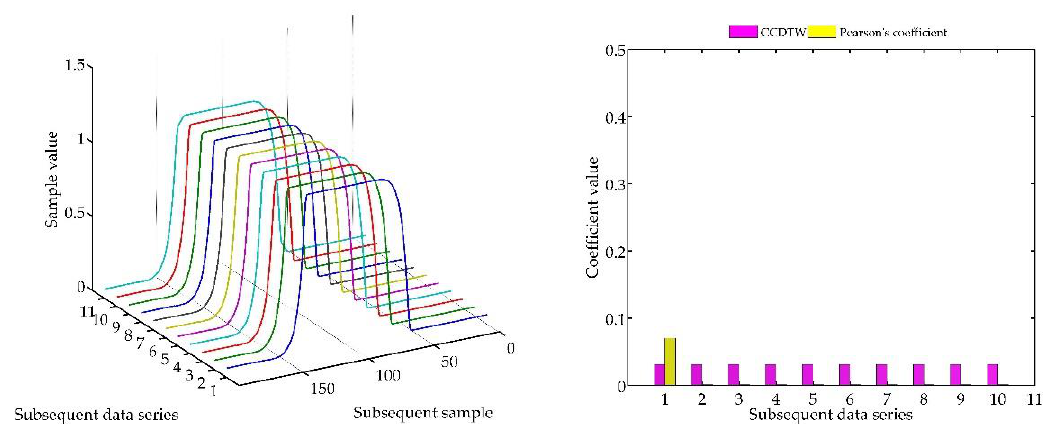
Figure 10. Simulation results achieved for data shifted by − 5 samples for the first series (blue line) for r ampl = 2.